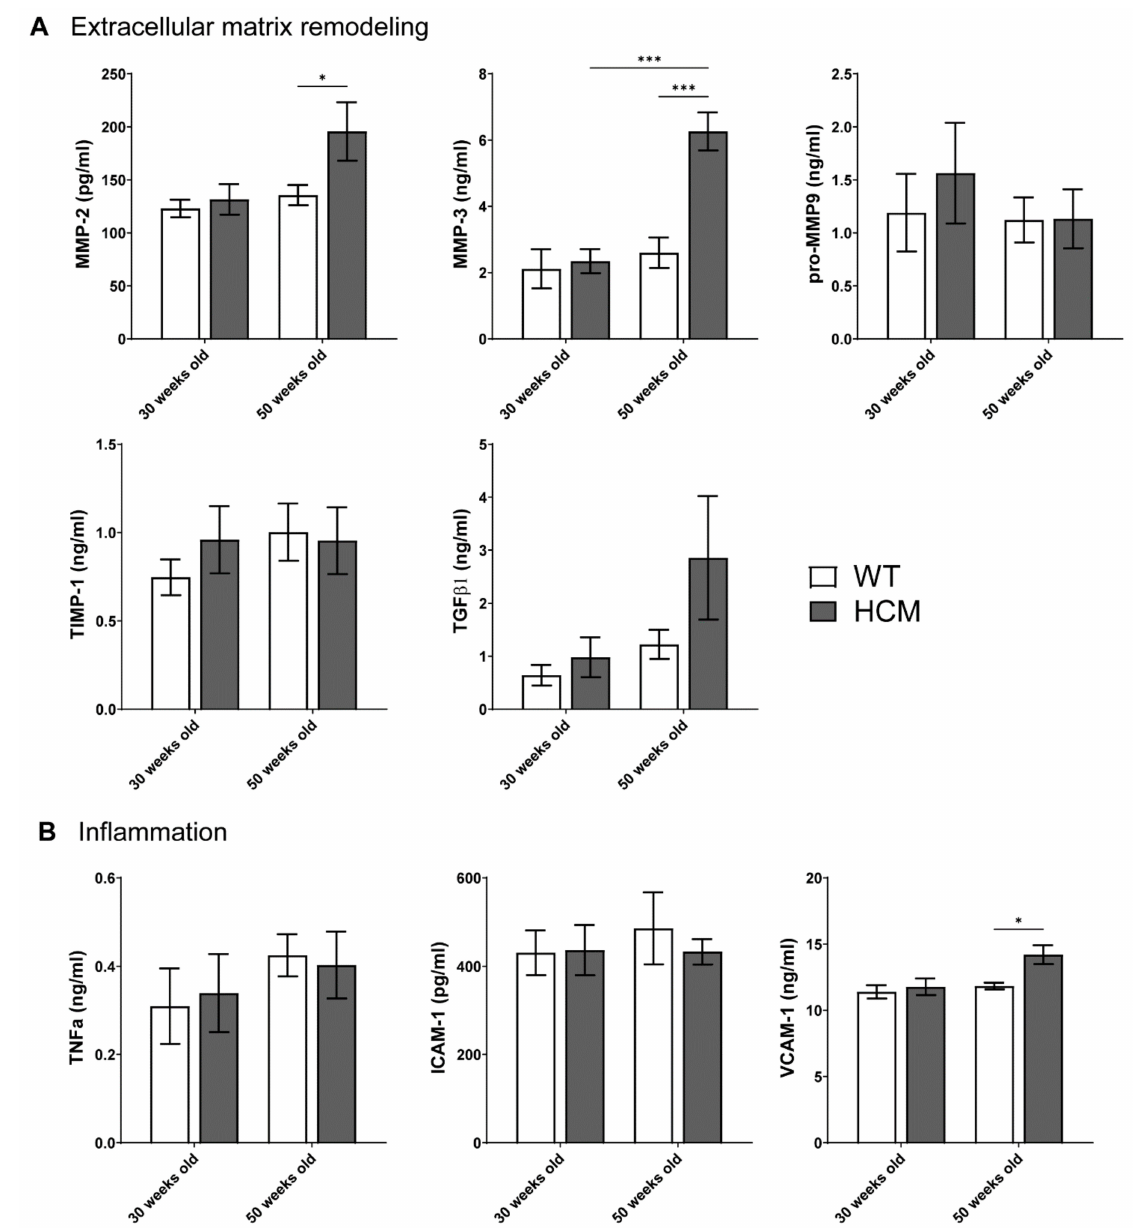
Figure 5. Circulating plasma biomarkers of extracellular matrix and inflammation. ( A ) Plasma levels of extracellular matrix biomarkers MMP-2, -3, pro-MMP-9, TIMP-1, and TGF β 1 in young and aged HCM mice compared to controls. ( B ) Plasma levels of inflammatory biomarkers tumor necrosis factor alpha (TNF α ), intercellular adhesion molecule 1 (ICAM-1), and vascular cell adhesion molecule 1 (VCAM-1) in both young and aged HCM mice compared to controls. * p < 0.05 and *** p <